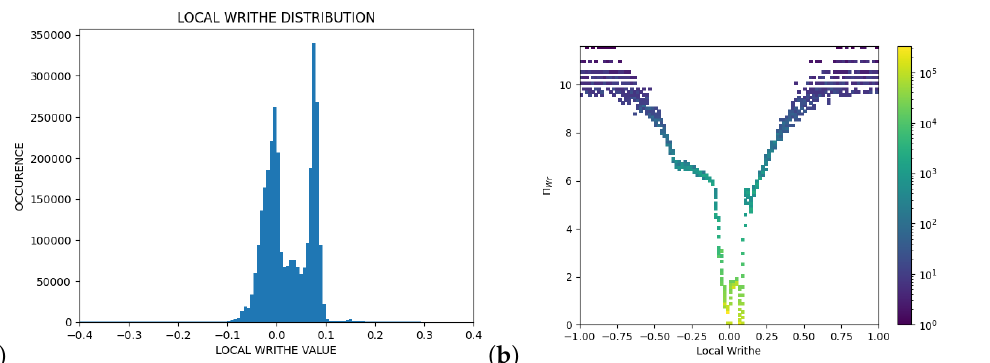
Figure 2. ( a ) The distribution of the local writhe values in the PDB sample. ( b ) The local topological free energy in writhe, Π Wr , in the PDB sample. Figure from [44]. The distribution of local torsion and Π T can be found in